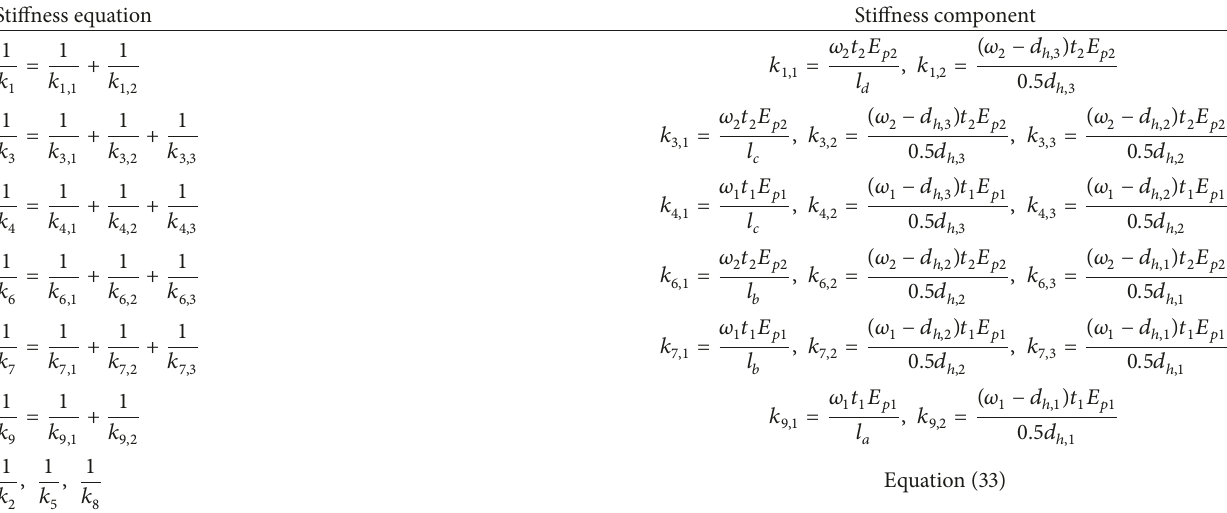
Table 5: Calculation of